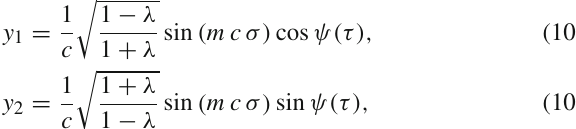
(86), but in terms of δ ˜ σ , defined in (68), instead of δσ . There are only rotating solutions of this form. The world-sheet of such solutions is